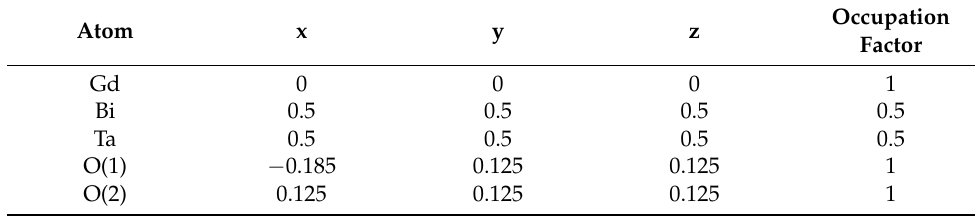
Figure 1. X-ray powder diffraction patterns and Rietveld refinements of Gd 2 BiTaO 7 (red dotted line represented experimental XRD data of Gd 2 BiTaO 7 ; blue solid line represented simulative XRD data of Gd 2 BiTaO 7 ; black solid line represented a difference between experimental XRD data of Gd 2 BiTaO 7 and simulative XRD data of Gd 2 BiTaO 7 ; green vertical line represented observed reflection positions). Table 1. Structural parameters of Gd 2 BiTaO 7 prepared by solid-state reaction